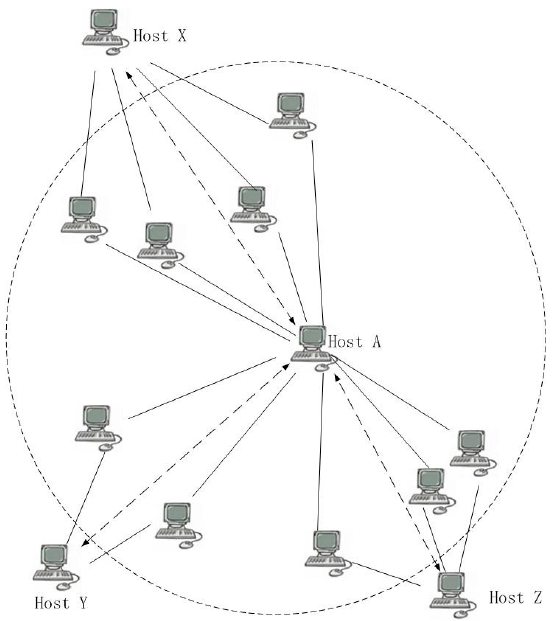
Figure 4. Network connection analytical model 3.